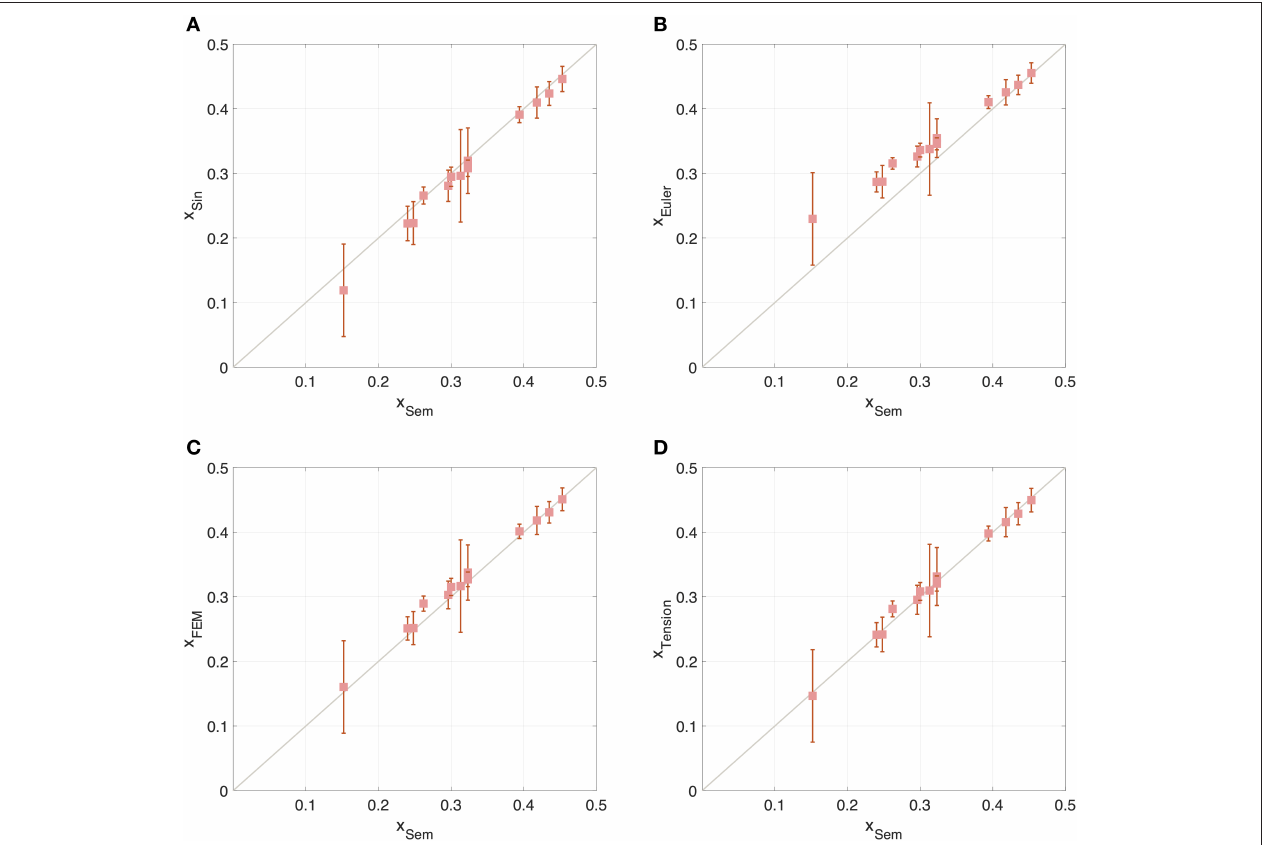
FIGURE 3 | Comparison of position values obtained by SEM characterization (x-axis) along the normalized beam length, and those obtained by NEMS (y-axis) using various mode shapes, (A) sinusoidal, (B) Euler-Bernoulli beam theory, (C) FEM simulation, and (D) the analytical solution with tension term. The data shown correspond to the 15 µ m